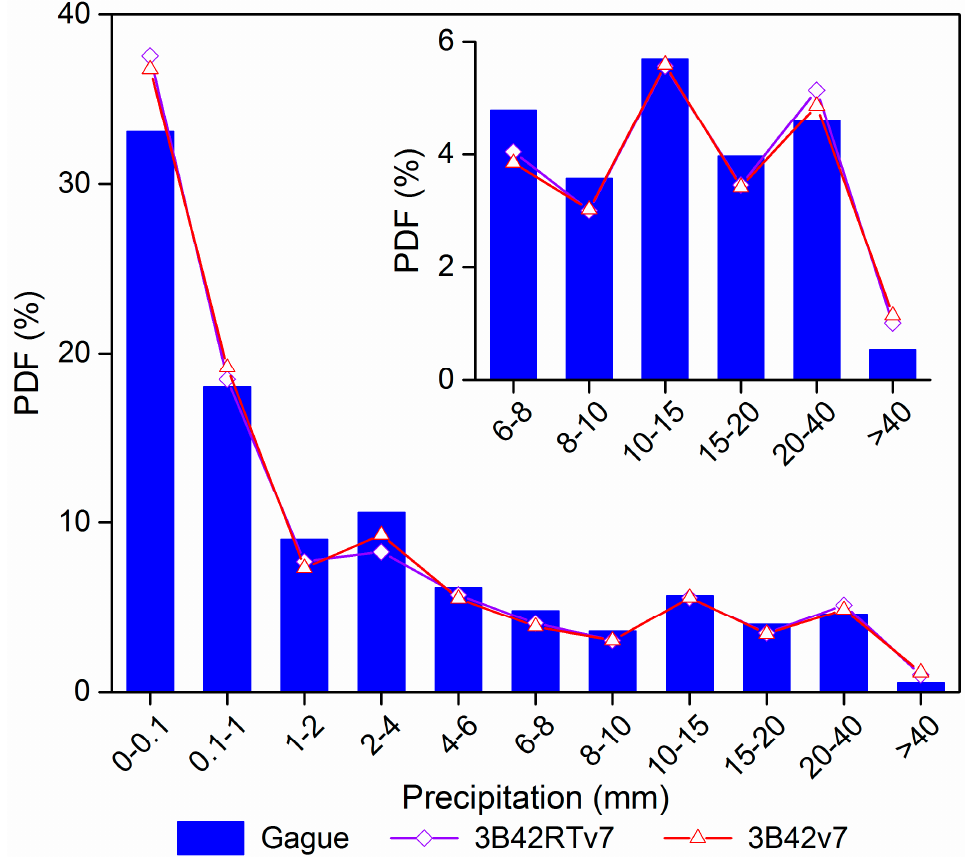
Figure 5. Probability density function (PDF) of daily precipitation classified by different intensities, as derived from 3B42RTv7, 3B42v7 and gauge datasets over 2000–2013. The small panel in the upper right corner descripted the PDF of daily precipitation more than 6.0 mm.